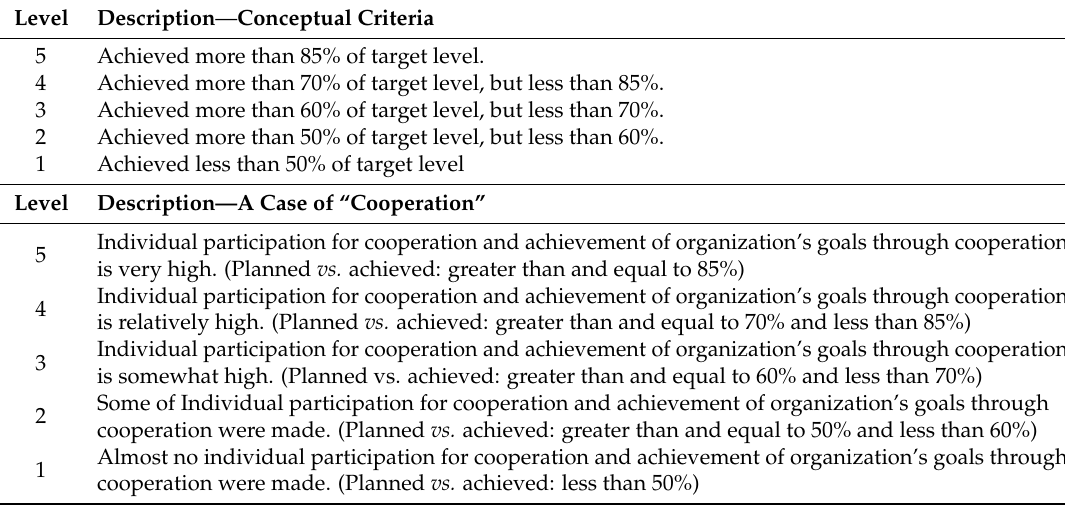
Table 3. Goal based rating criteria.